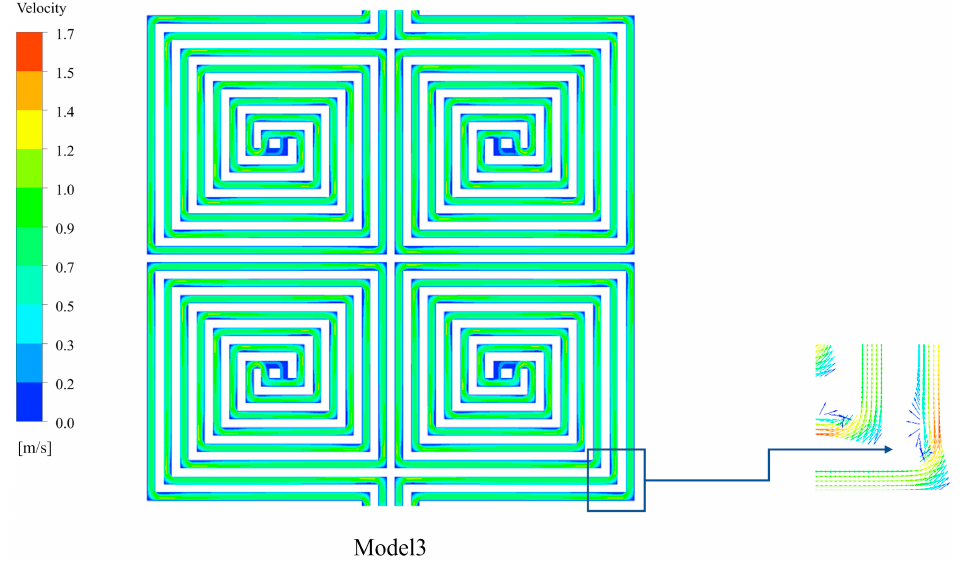
Figure 8. Local velocity of multi-helical flow field.